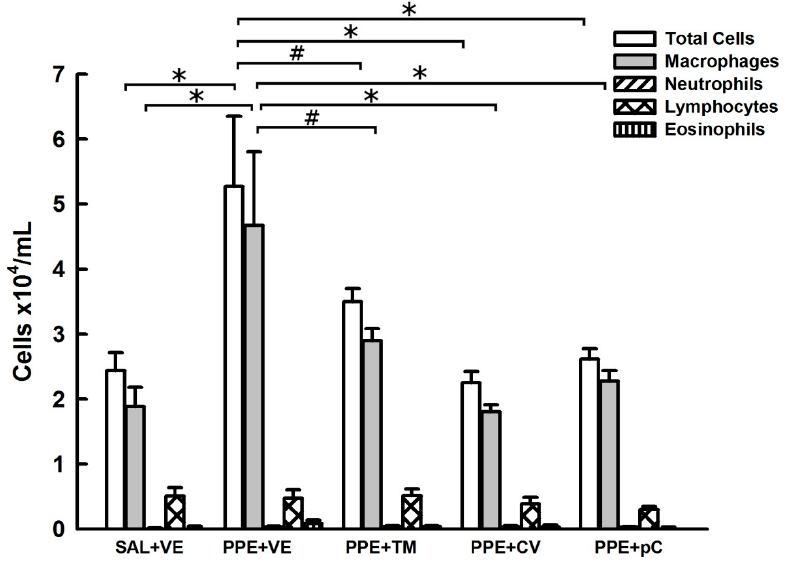
Figure 2. Effects of monoterpenes p -cymene, carvacrol and thymol on lung inflammation . Data are presented as mean ± standard error (SE) ( n = 7 to 8 mice/group) of number of cells recovered in bronchoalveolar lavage fluid collected at the 28th day of the experimental protocol. SAL + VE: control group with vehicle treatment; PPE + VE: porcine pancreatic elastase instillation and vehicle treatment; PPE + TM: porcine pancreatic elastase instillation and thymol treatment; PPE + CV: porcine pancreatic elastase instillation and carvacrol treatment; PPE + pC: porcine pancreatic elastase instillation and p -cymene treatment. * p < 0.01 and # p < 0.05.